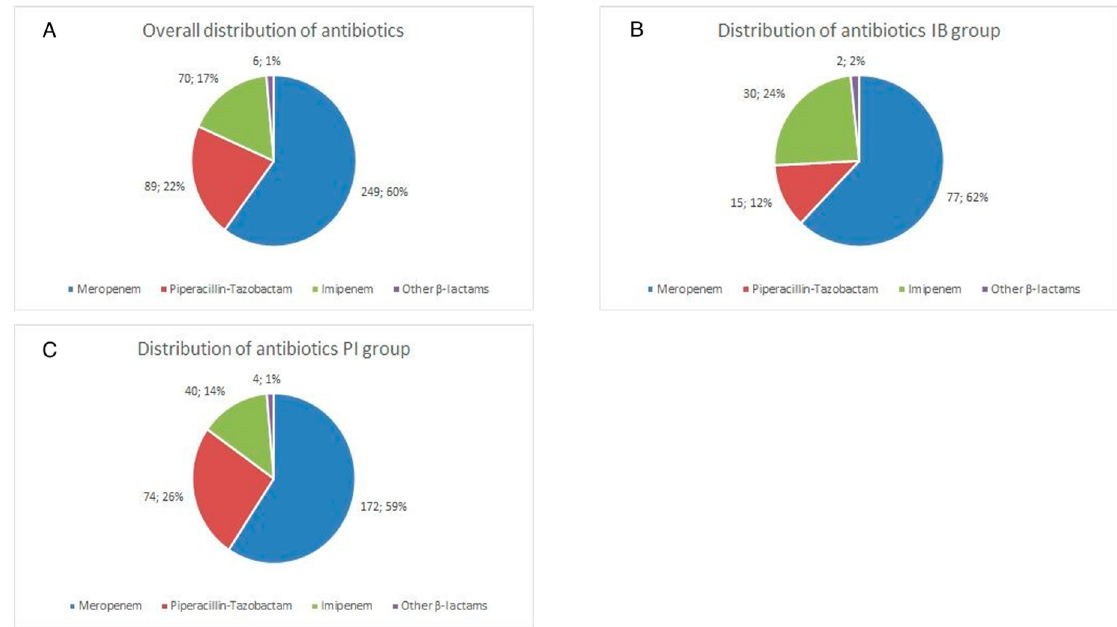
Figure 1. Distribution of Antibiotics in ( A ) Entire Cohort, ( B ) Intermittent bolus (IB) group and ( C ) prolonged infusion (PI)